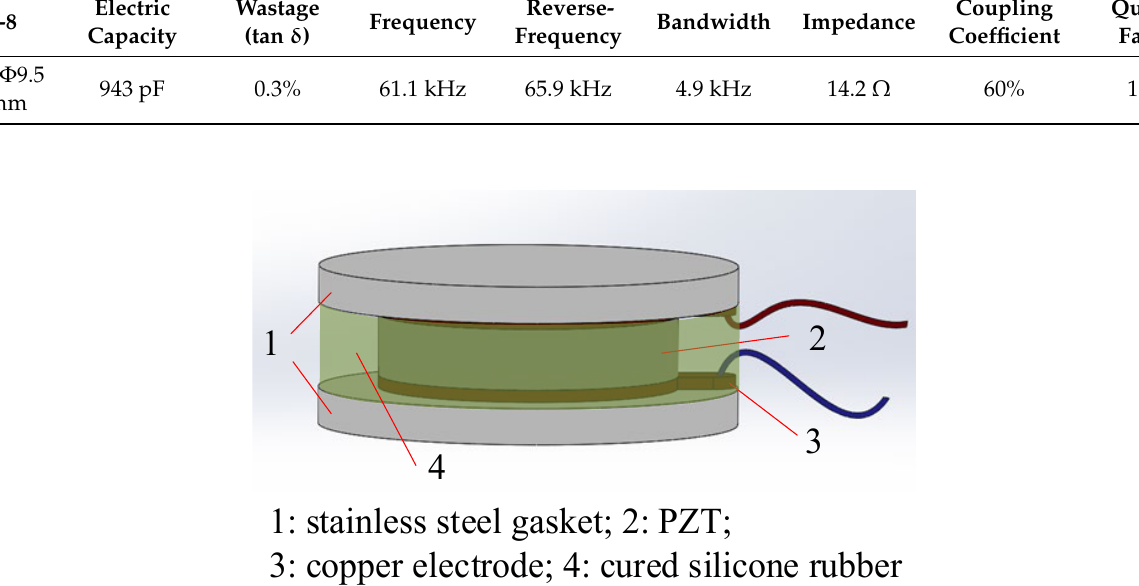
Figure 3. Structure of piezoelectric sensing unit.